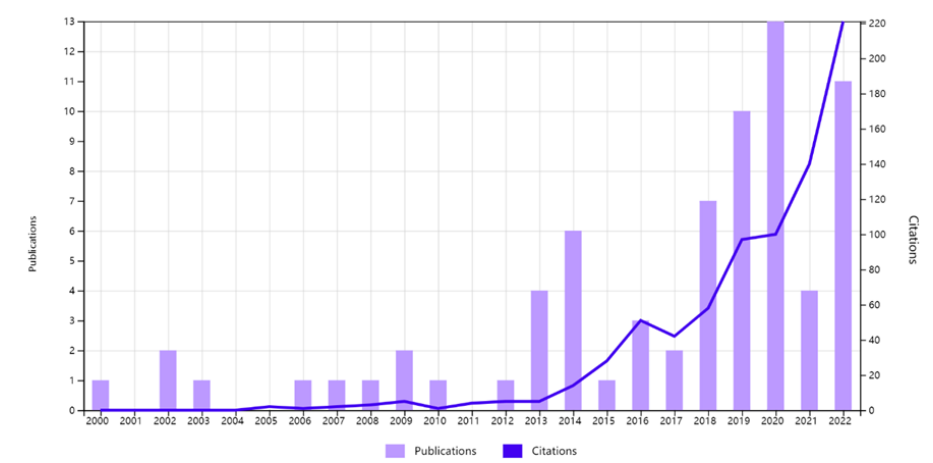
Figure 2. Literature publication and citation report in Web of Science .